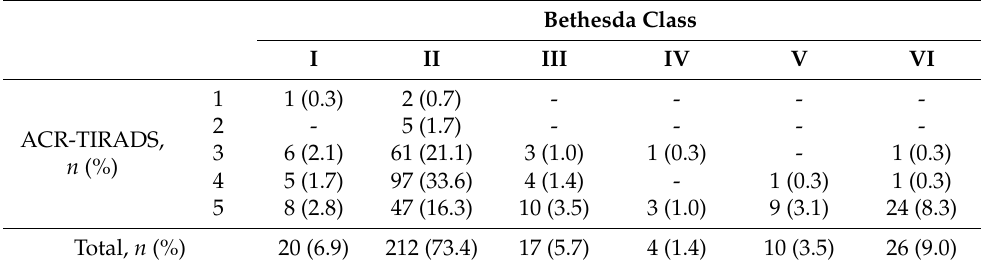
Table 4. Summary of ACR-TIRADS categories by Bethesda